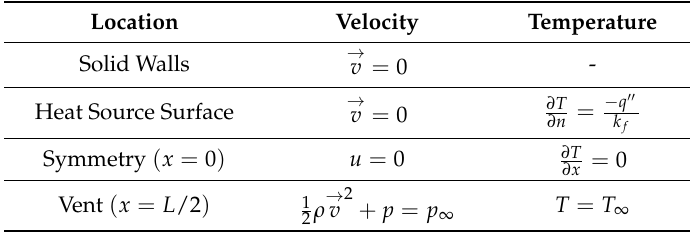
Table 2. Boundary Table 2. Boundary conditions.